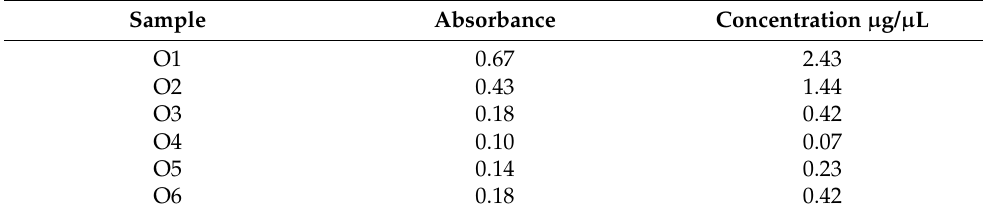
Table 1. Protein concentration estimate with the BCA method for six specimens (O1–O6) of O. vulgaris skin